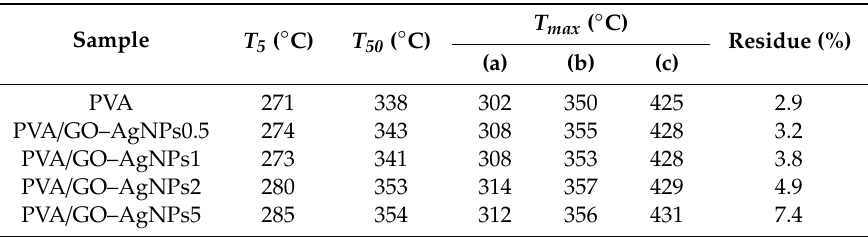
Table 3. TGA data for neat PVA and PVA/GO–AgNPs nanocomposites.